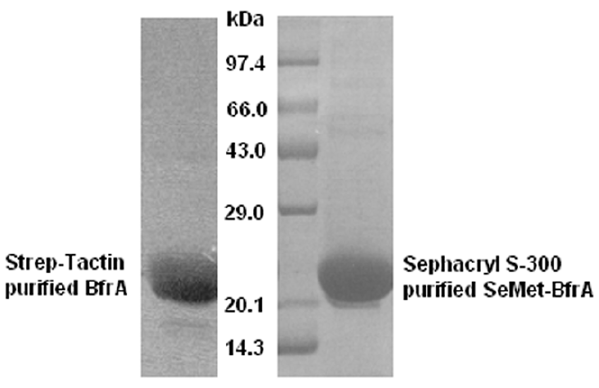
Figure 1. Purity of recombinant Mtb BfrA. 12.5% SDS-PAGE analysis of Strep-Tactin purified native BfrA vs Sephacryl S-300 purified SeMet-BfrA.